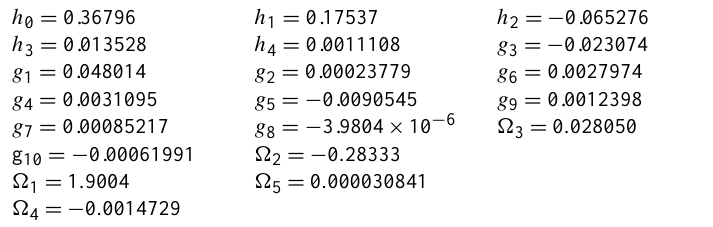
Table C1. Coefficients for use in the Anderson (1993) calculation of